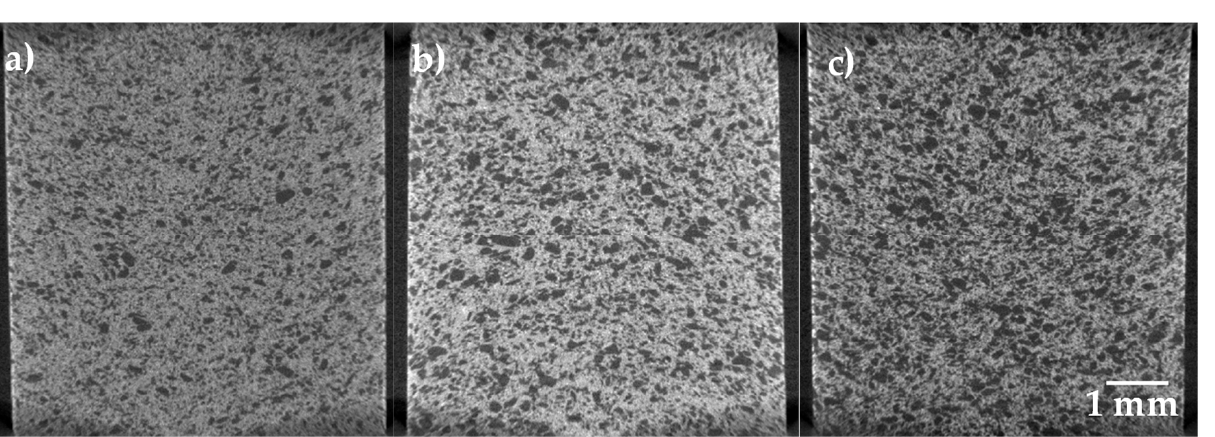
Figure 5. 2D virtual slices of the Ti64/20Ag samples after sintering at 1100 °C, acquired with a pixel resolution of 6.5 µm and with different quantities of pore formers: ( a ) 30 vol.%, ( b ) 40 vol.% and ( c ) 50 vol.%. Table 2. Pore characteristics of Ti64/20Ag samples fabricated with different vol.% of pore formers. Volume Fraction of Pore Volume Fraction of Pore Connectivity Formers (%) Pores (%)